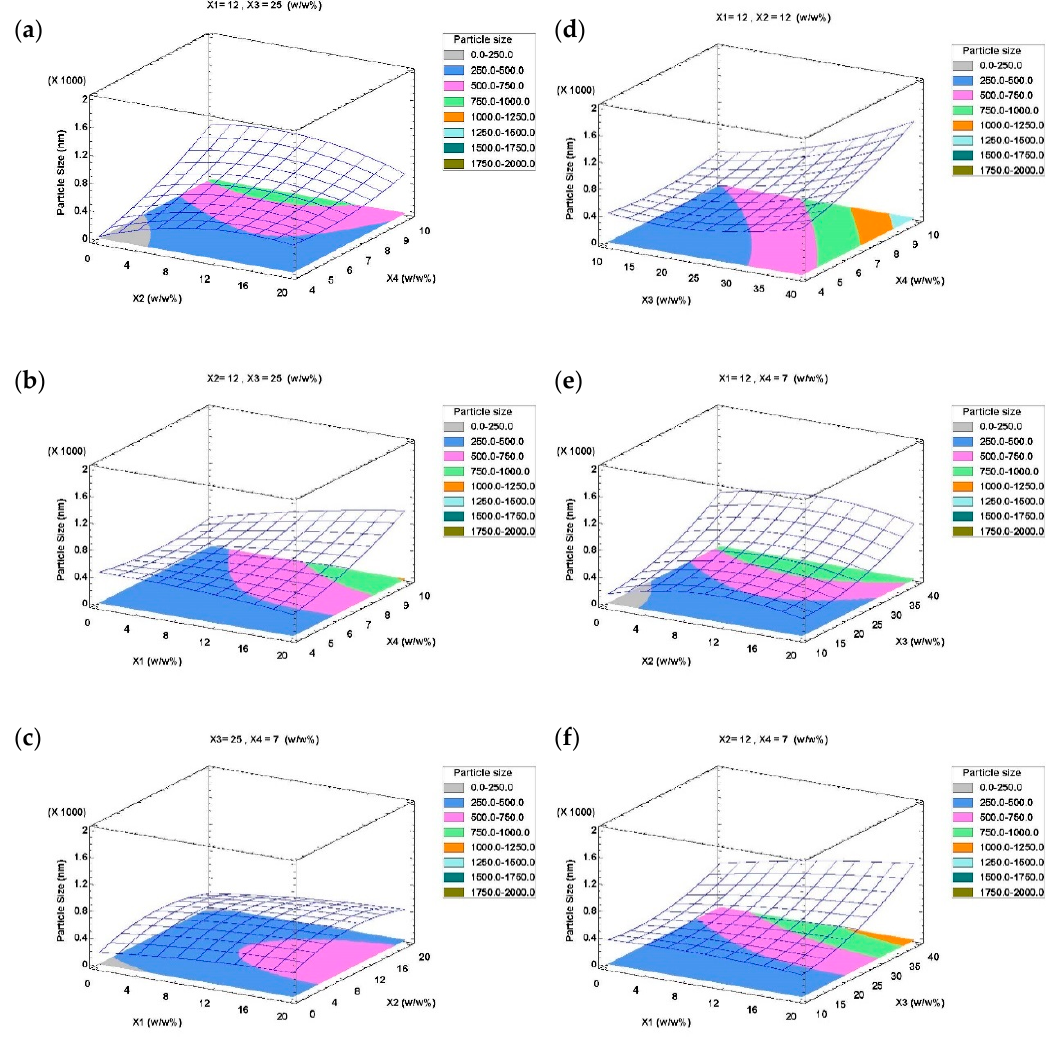
Figure 1. Response surface plots of interactions between two input factors, while holding the other two constants at their central points, on particle size of W / O / W emulsions. X 1 : Aqueous phase content in W / O emulsion; X 2 : Surfactant content in W / O emulsion; X 3 : W / O content in W / O / W emulsion; X 4 : Surfactant content in W / O / W emulsion. ( a ) X 2 vs. X 4 ; ( b ) X 1 vs. X 4 ; ( c ) X 1 vs. X 2 ; ( d ) X 3 vs. X 4 ; ( e ) X 2 vs. X 3 ; ( b ) X 1 vs. X 3 .